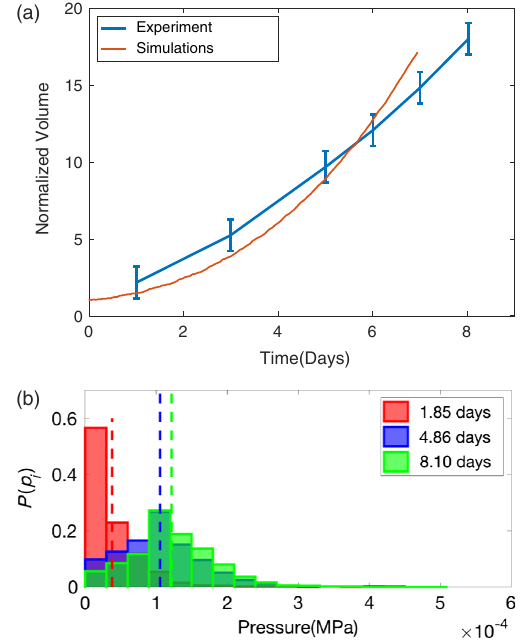
FIG. 3. (a) Normalized volume V ð t Þ =V 0 of a tumor spheroid as a function of time. The result of the simulation (red) agrees nearly quantitatively with experimental data obtained for the tumor spheroid growth at an applied pressure of 500 Pa [42]. We used a 100 Pa and cell division time of τ ¼ τ critical pressure p in c ¼ min these simulations. The reason for comparing the results from the 100 Pa simulations with the growth dynamics obtained in p c ¼ the colon carcinoma cells with an external pressure of 500 Pa is explained in the text. (b) Distribution of pressure as a function of 0 . 625 days. total growth time with cell division time τ ¼ τ min ¼ The mean values are indicated by the dashed